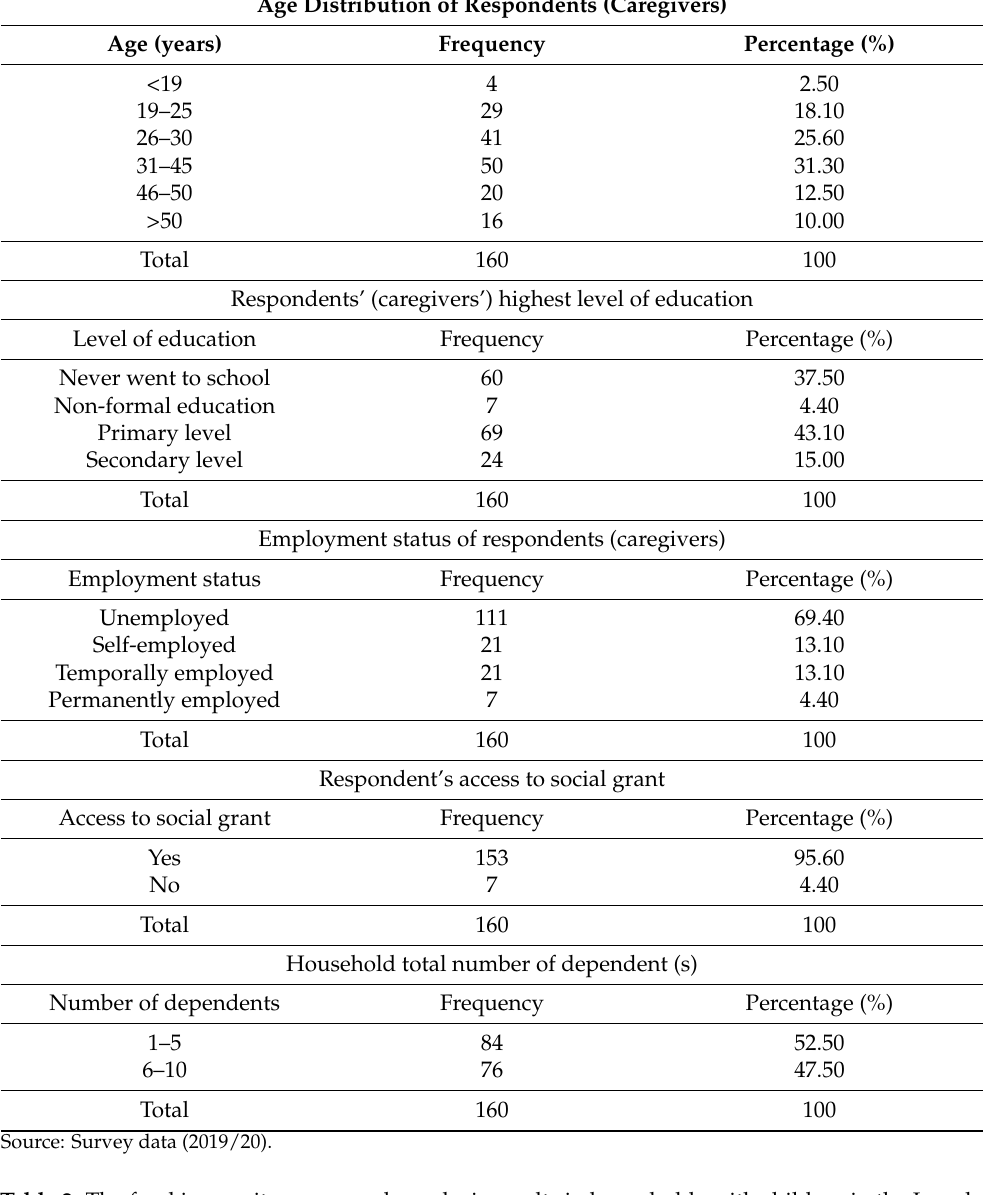
Table 2. The food insecurity access scale analysis results in households with children in the Inanda informal